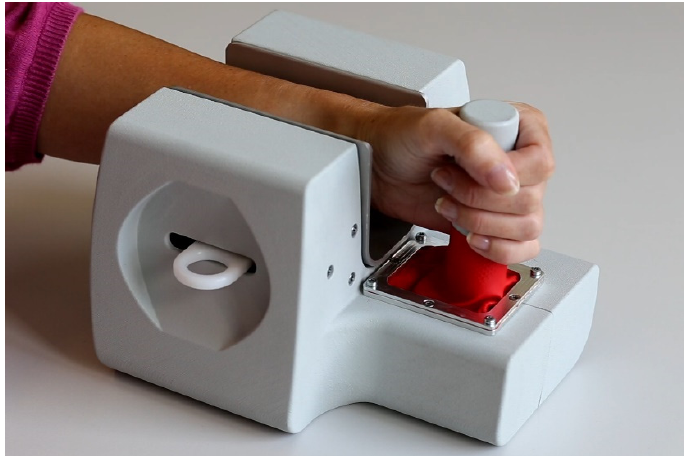
Figure 2. The portable integrated ultrasound ‐ based measurement device tested and evaluated. Two array transducers with four elements each gently press against the arm laterally and medially, respectively. Both transducer arrays on each side of the arm are used for acquiring pulse ‐ echo reflection signals and receiving transmission signals. To increase the chances of measuring the potentially existing growth plate, the system moves all transducers in distal and proximal directions during data acquisition while the subject is holding a grab handle tightly with her hand. The use of US array transducers eliminates the need to reposition the transducer as the skin’s elasticity permits epidermal movements of up to 15 mm. The grab handle restrains the subject’s arm movements, preventing any involuntary actions, while the transducers are moving along the wrist and arm. It also serves as a reference point for the arm, reducing the variation in measurement location.